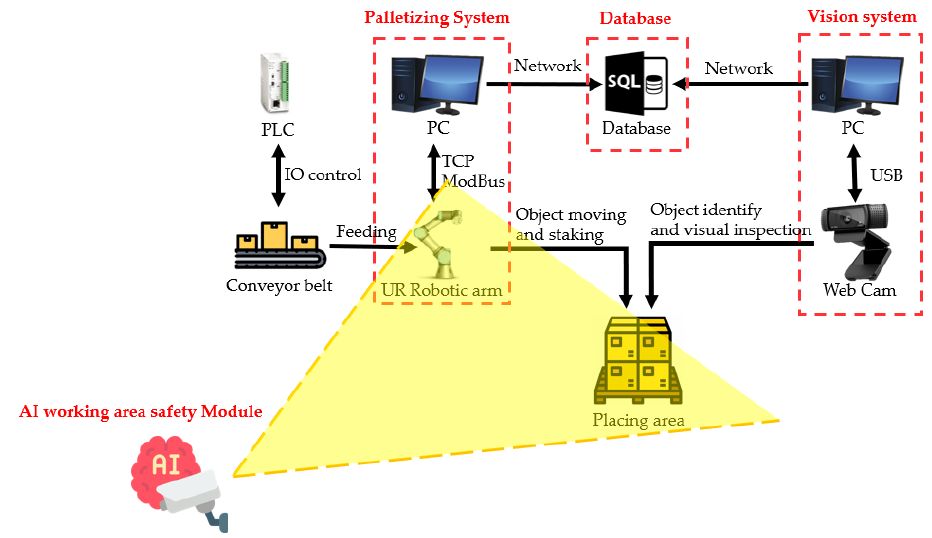
Figure 35 . The system architecture of the workstation.